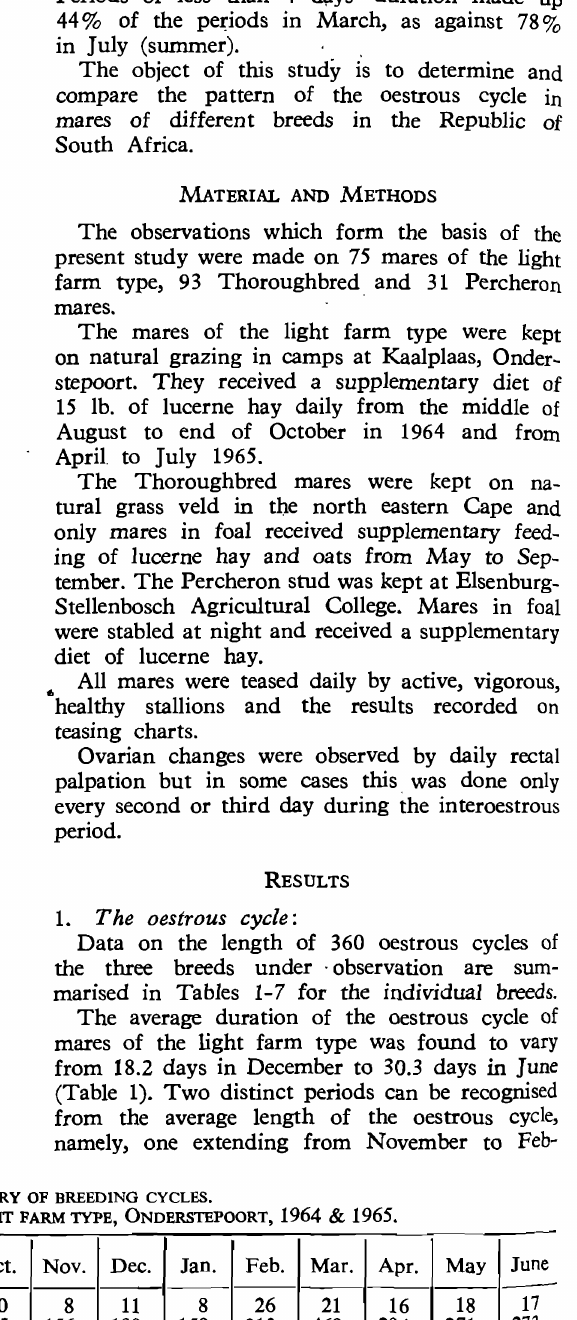
TABLE I.-SUMMARY OF BREEDING CYCLES. OESTROUS CYCLES OF MAIU:S OF THE LIGHT FARM TYPE, ONDERSTEPOORT, 1964 & 1965. Aug.